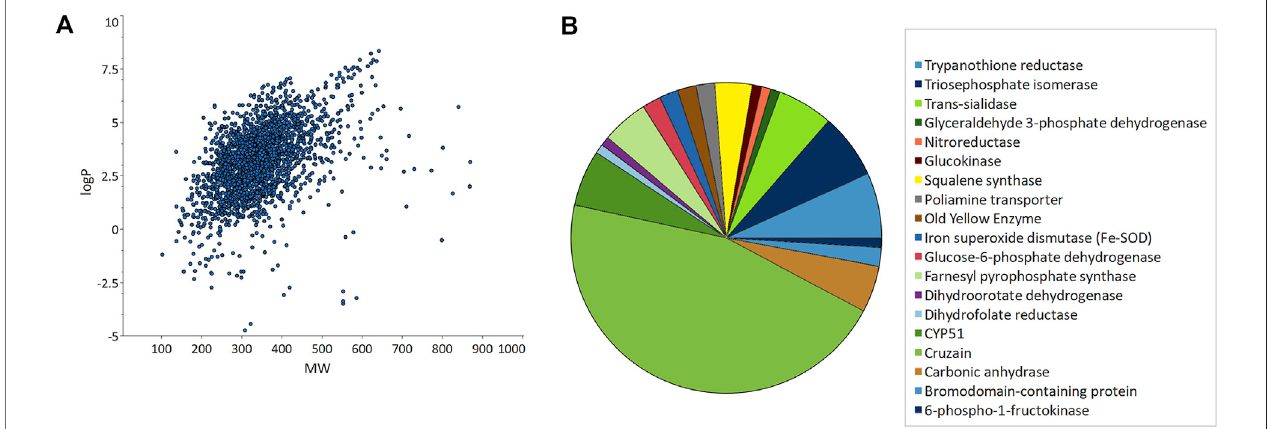
FIGURE 2 | Unique compounds data obtained from ChEMBL. (A) Calculated lipophilicity (clogP) vs. molecular weight (MW) plot. (B) Molecular targets commonly explored in Chagas disease drug-discovery campaigns.